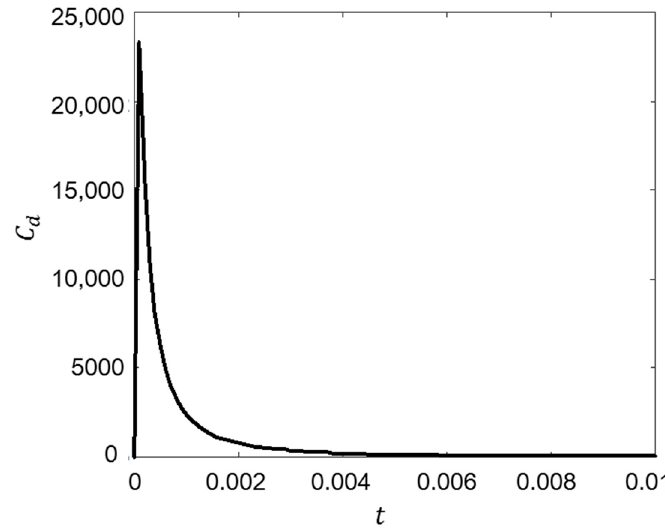
Figure 8. Overshoot phenomenon of drag force